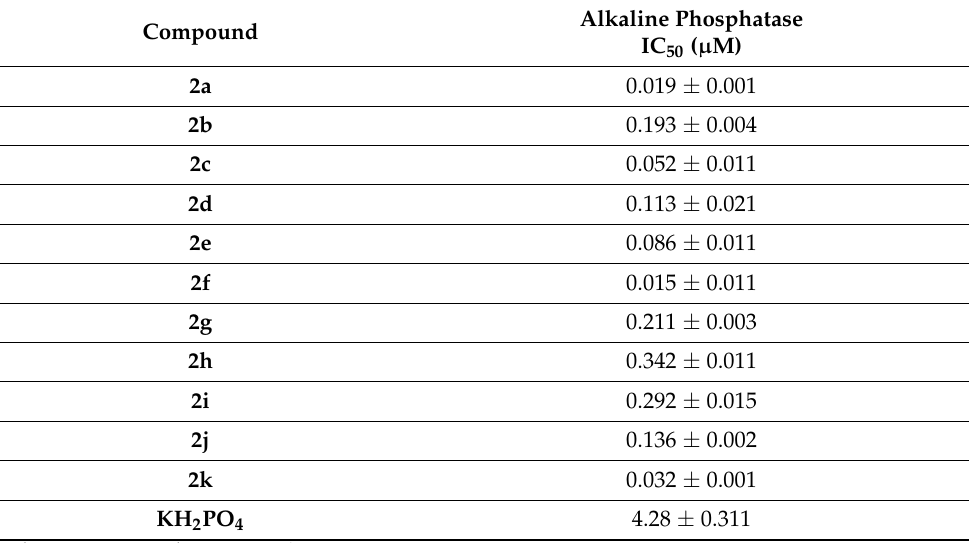
Table 1. Alkaline phosphatase inhibitory activity of compounds 2a – 2k .